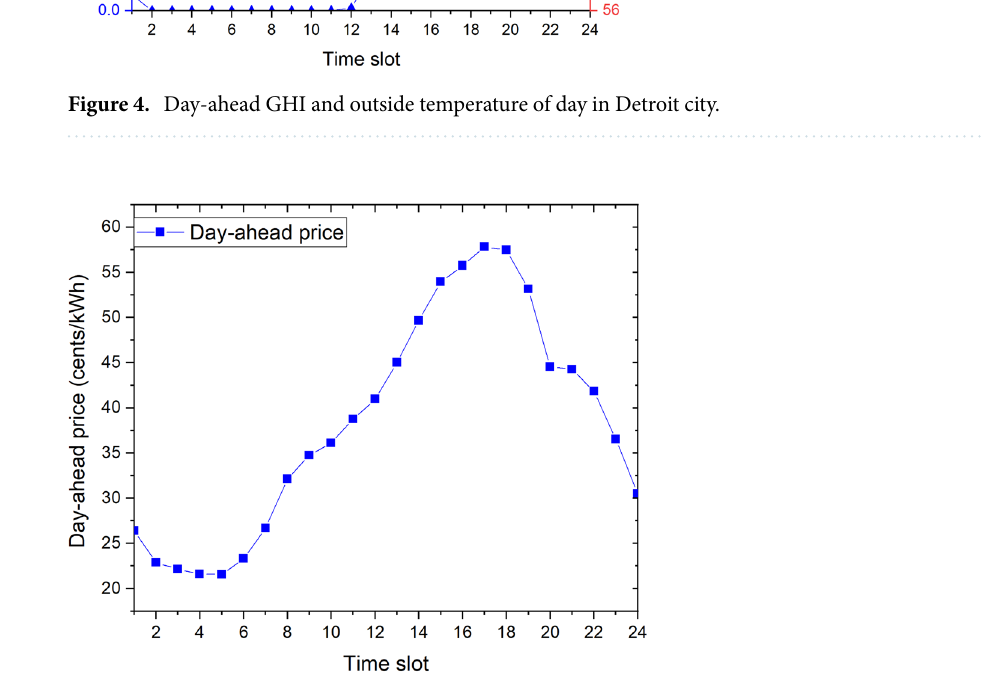
Figure 5. Day-ahead prices of day in Michigan